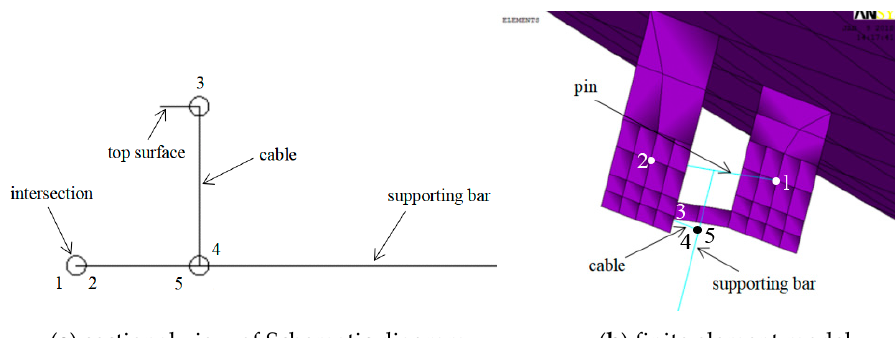
Figure 5. Modeling details of revolute joint.